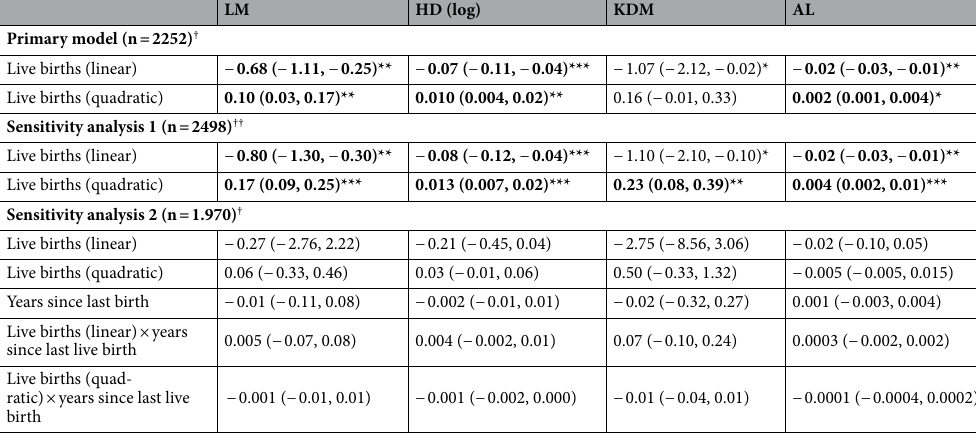
1617. The average years since last live birth was 8.87 (SE = 0.19). After correcting for multiple comparisons, the main effect of years since last live birth was not significant in any model, nor were any of the interaction terms between years since last live birth and parity (Table 2). Our sample size for analyses including months since last live birth ( n = 107) was significantly limited by the fact that this subsample excluded all post-menopausal women, and excluded women sampled prior to this ques- tion being added in the 2007–2008 cycle. On average, women with valid responses to this question gave birth 10.7 months ago (SE = 0.63). After correcting for multiple comparisons, the main effects of months since last live birth and parity was not significant in any model, nor were any of the interaction terms between months since